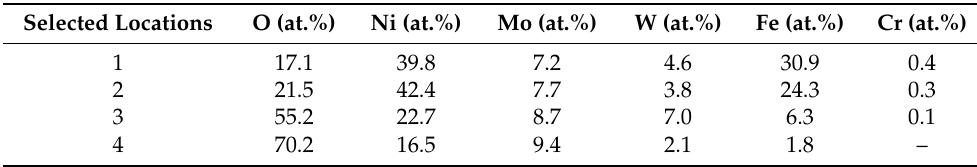
Table 3. The chemical composition acquired corresponding results of EDS spectra for the select locations in Figure